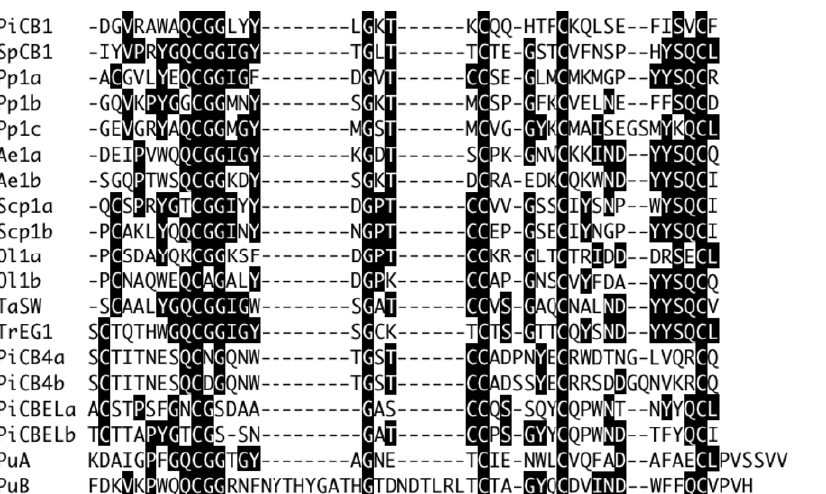
Figure 5. Comparison of a selection of cellulose binding domain (Carbohydrate Binding Module 1) proteins by alignment of conserved regions. PiCB1, Phytophthora infestans (CBD1) ABW76417; SpCB1, Saprolegnia parasitica AAZ94039; Pp1a, Pp1b and Pp1c, Porphyra purpurea AAA61792; Ae1a and Ae1b, Aphanomyces euteiches Ae_11AL5933; Scp1a and Scp1b, Schizosaccharomyces pombe NP_593986; Ol1a and Ol1b, Ostreococcus lucimarinus ABO94230; TaSW, Trichoderma asperellum ACB05430; TrEG1, Trichoderma reesei AAA34212; PiCB4a and PiCB4b, Phytophthora infestans (CBD4) ACL80756; PiCBELa and PiCBELb, Phytophthora infestans (CBD5) ACM68430; PuA and PuB, Pythium ultimum (CBD4) ADOS01001693. Arrow indicates previously reported site of mutation of tyrosine residue (ref. 17), found on the outer, non-cellulose binding face of the CBM1 of TrEG1. Designations of a, b and c refer to repeated CBM motifs within the same protein.